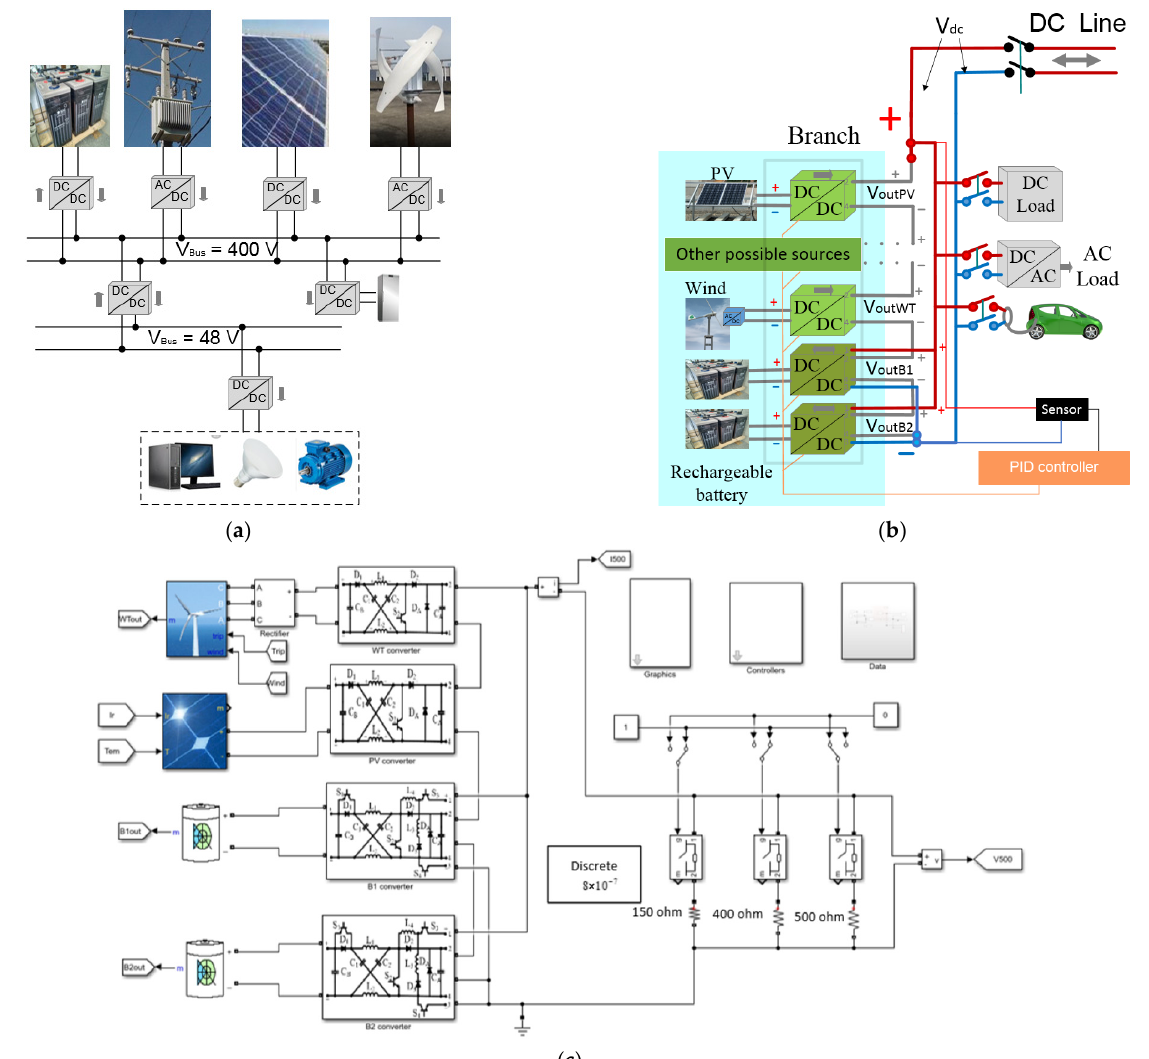
Figure 5. Source coupling: ( a ) Classical structure, ( b ) Proposed coupling scheme, ( c ) Simulink ® model of the proposed coupling.